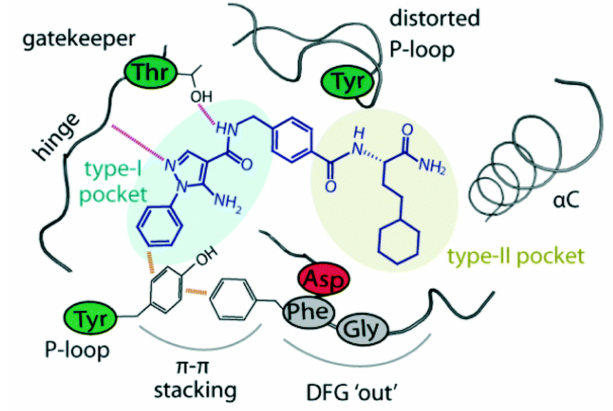
Figure 65. Binding mode of compound 59 with p38 α crystal structure